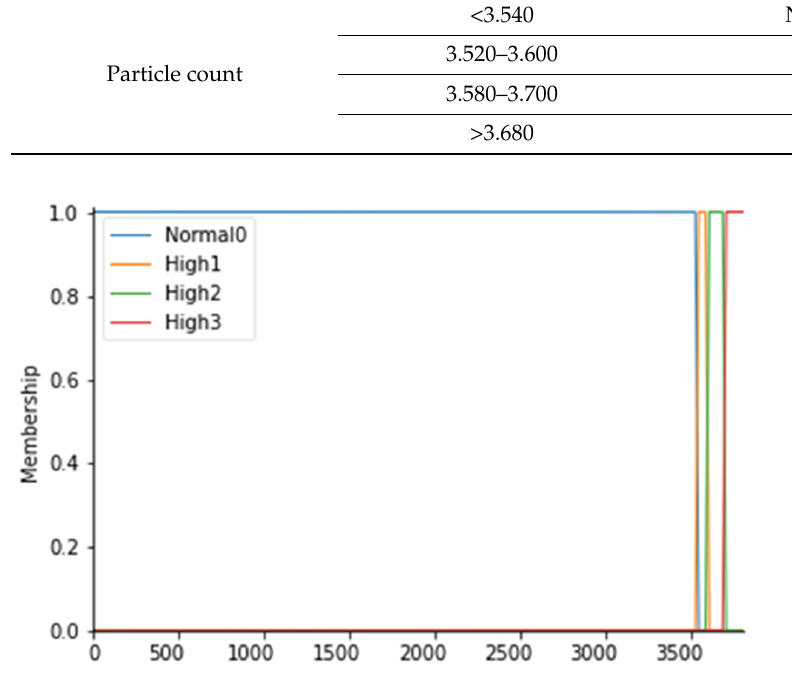
Figure 3. PC membership functions.